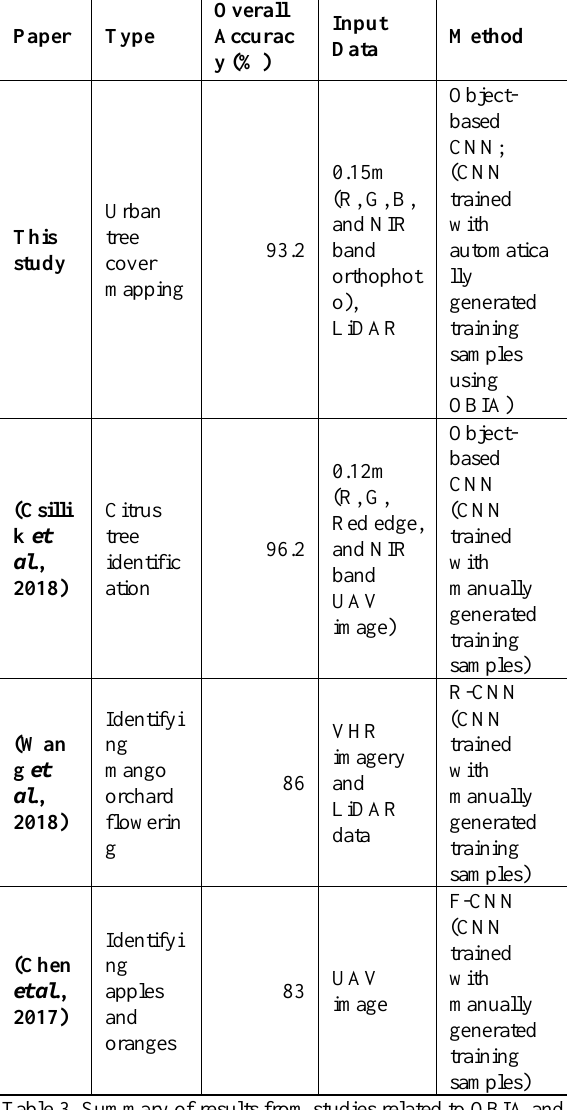
Table 3. Summary of results from studies related to OBIA and CNN for vegetation analysis.